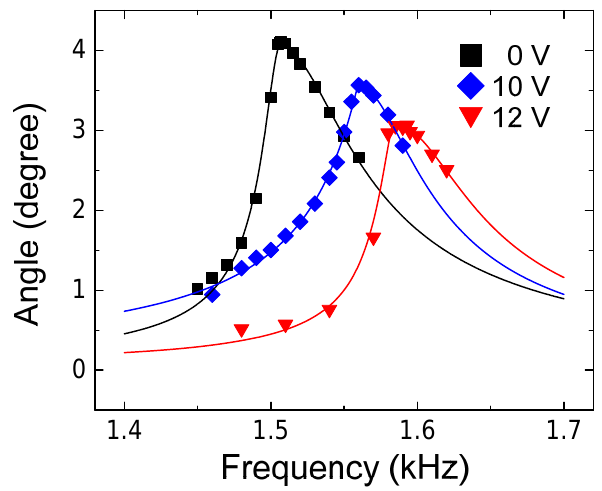
Figure 9. Frequency response change achieved by the shaft ‐ widening type. Data points are fitted with the Lorentzian function.